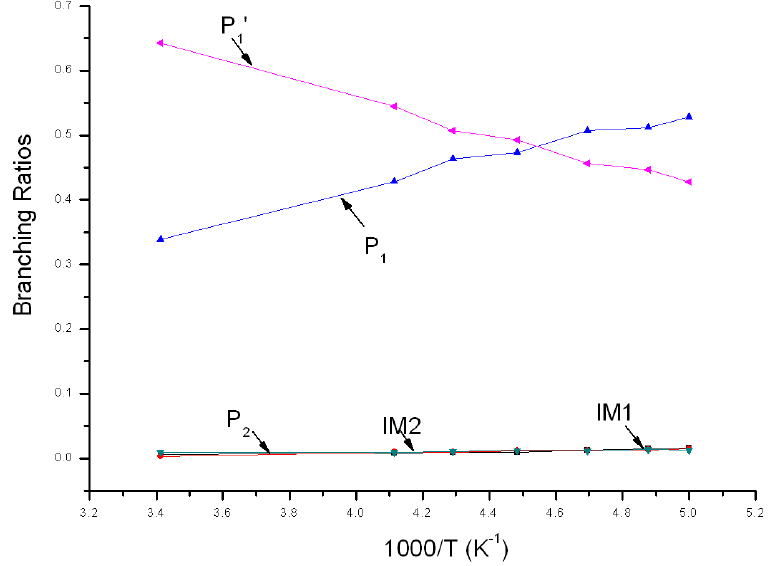
Figure 7. Branching ratios of various reaction channels at 7600 Torr in a temperature range from 200 K to 293 K